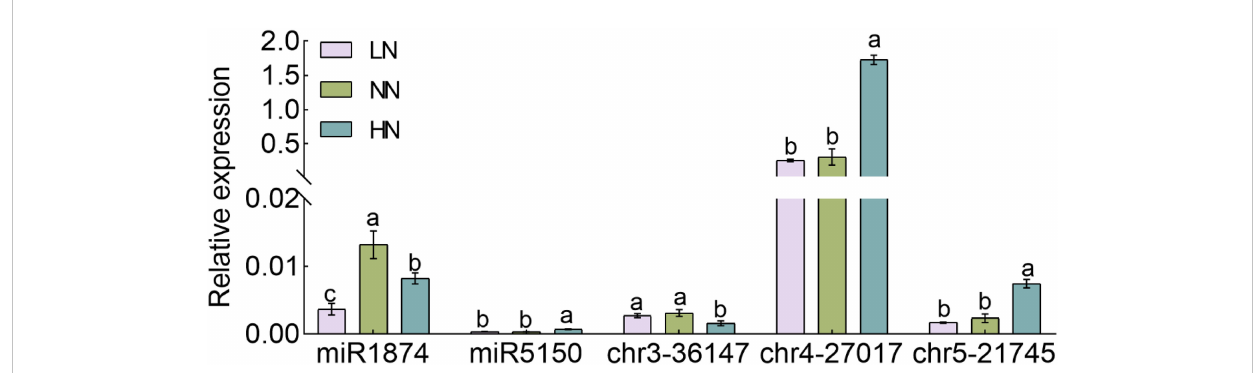
FIGURE 7 The expression of novel miRNA under different nitrogen treatment. Seedlings of rice cultivated, Nipponbare, in hydroponics for three weeks and were grown under nitrogen de fi cient conditions for three days, followed by treating with 0.125 mM NH 4 NO 3 (LN), 1.25 mM NH 4 NO 3 (NN) and 2.5 mM NH 4 NO 3 (HN) for one week. The RNA samples of Nipponbare were extracted one week after the treatment. The expressions of miR1874, miR5150, chr3-36147, chr4-27017, chr5-21745 were taken. Error bars: SD (n = 3). Signi fi cant differences between different lines are indicated by different letters ( P < 0.05, one-way